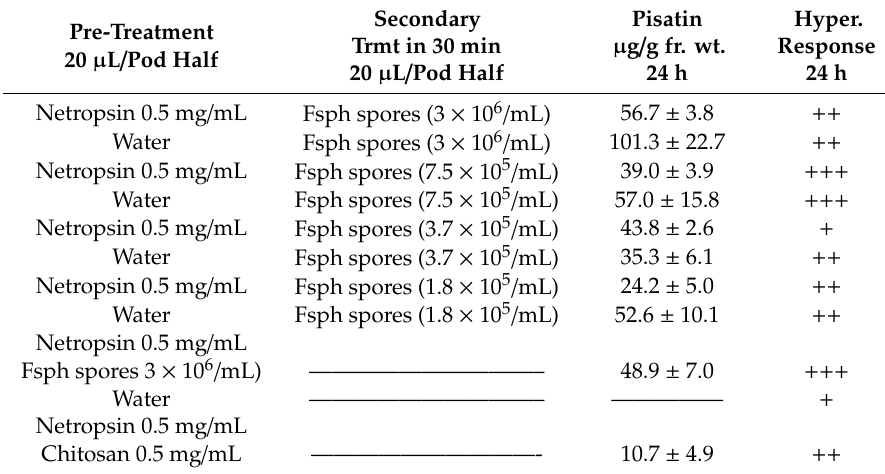
Table 2. Induction of pisatin production employing concentrations of netropsin and chitosan previously signaling marginal levels of pisatin and 18 C incubation temperatures following pea tissue treatments were employed to reveal possible symbiotic actions. Treatments were applied to pea endocarp tissue at 20 µ L / pod half. Pisatin extracted in hexane was quantitated at 309 nm. Fsph = Fusarium solani f. sp. phaseoli spores. Hypersensitivity was arbitrarily represented with the + symbol to indicate the relative